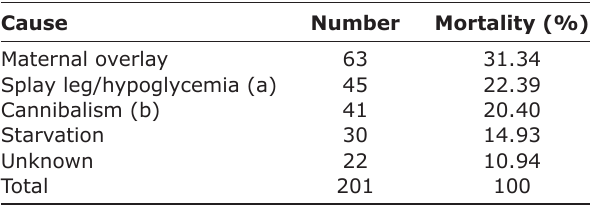
Table-2: Identified causes of PPM in pig farms in